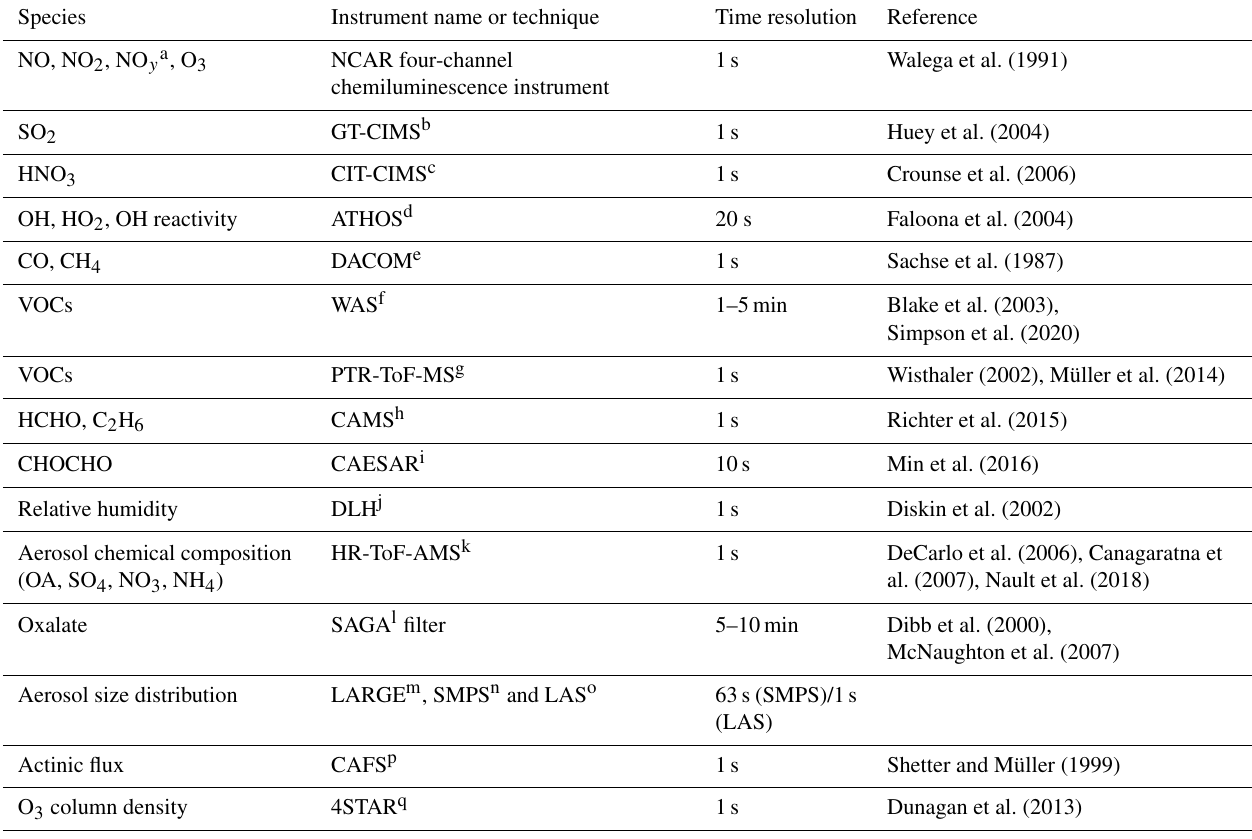
Table 1. Measurements from DC-8 used in this study.